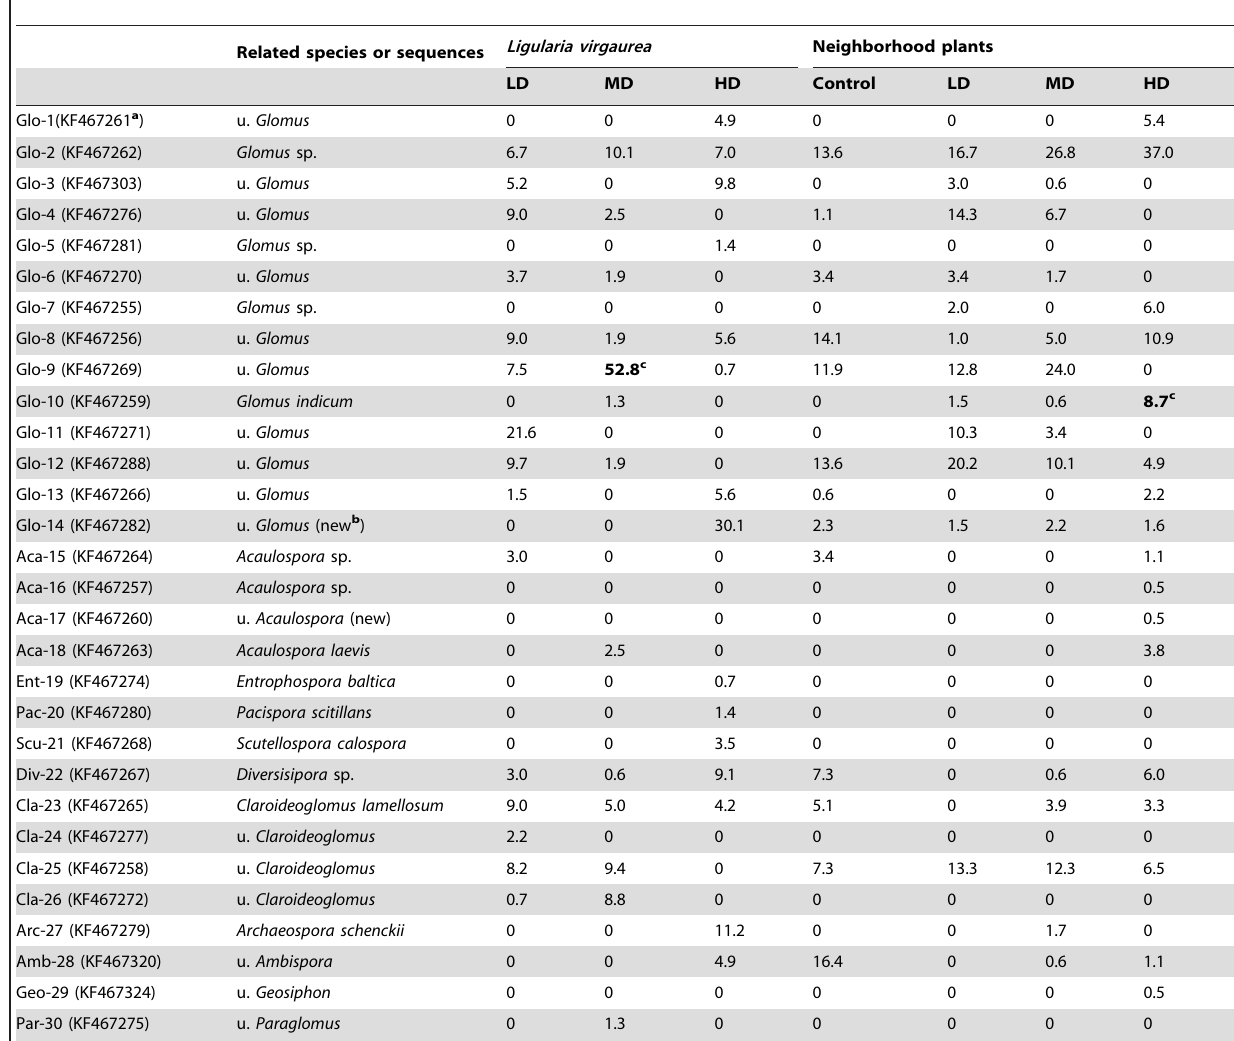
Table 1. Relative abundance (%, proportion of clone numbers) of each arbuscular mycorrhizal fungal phylotype and indicator species in the roots of Ligularia virgaurea and its neighborhood plants in different